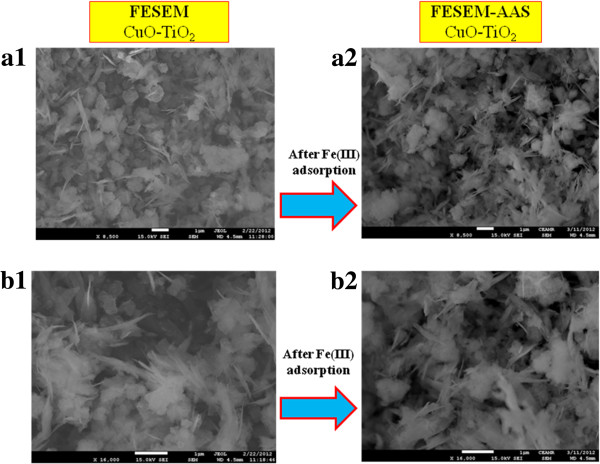
Schematic representation and FESEM images of (a) before and (b) after Fe(III) adsorption on CuO-TiO2 NSs.